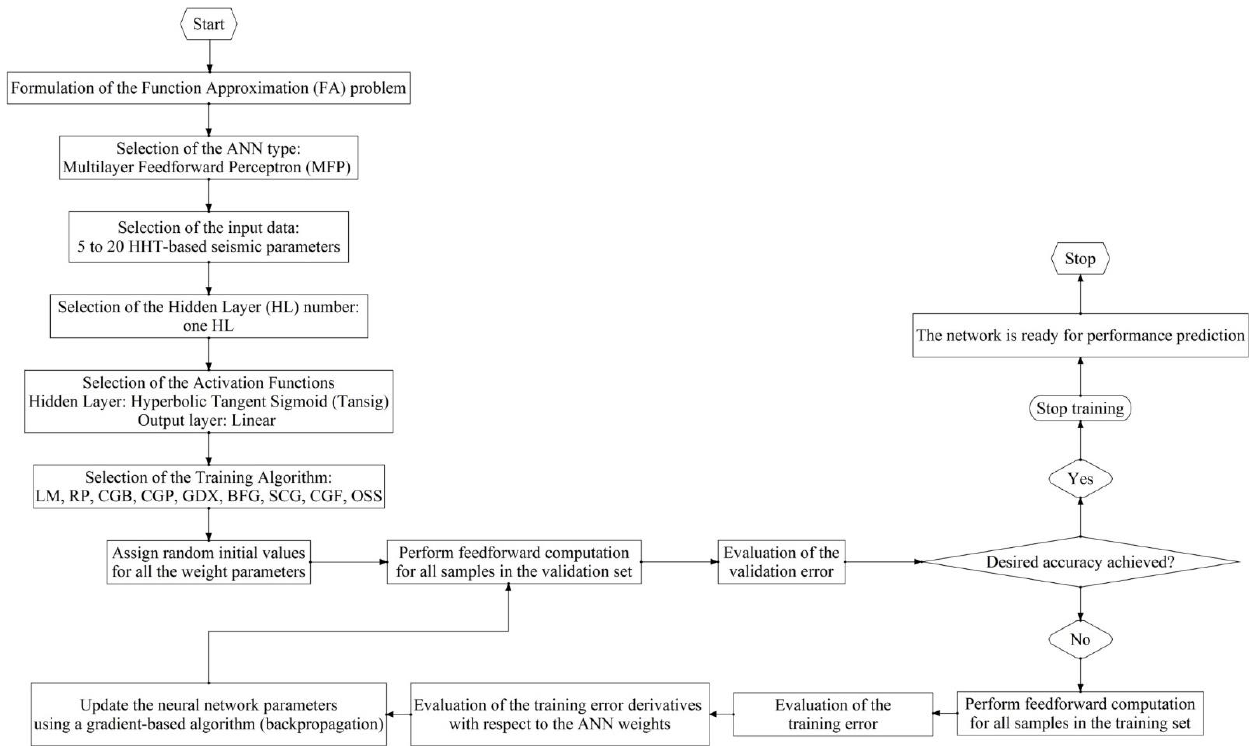
Figure 7. Flowchart of ANN computational procedures. Table 4. Statistics of R—ANNs with input parameters of Group 1. Group 1—R